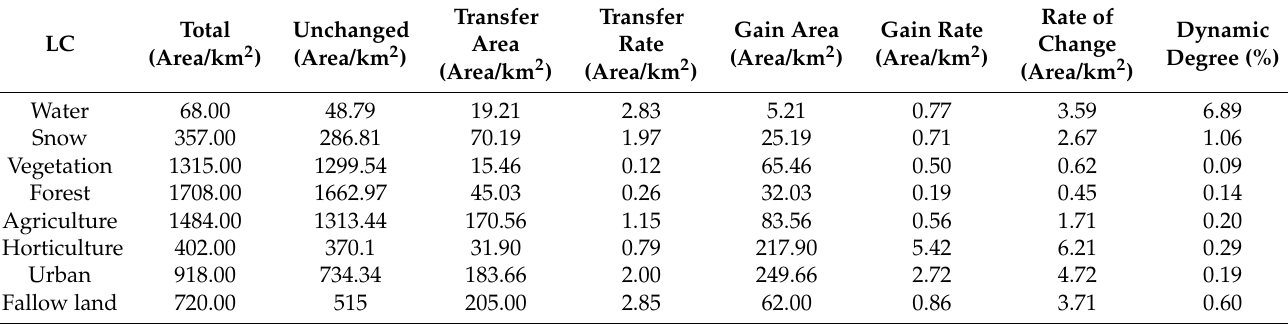
Table 6. The rate of LULC change during the 2010– 2020